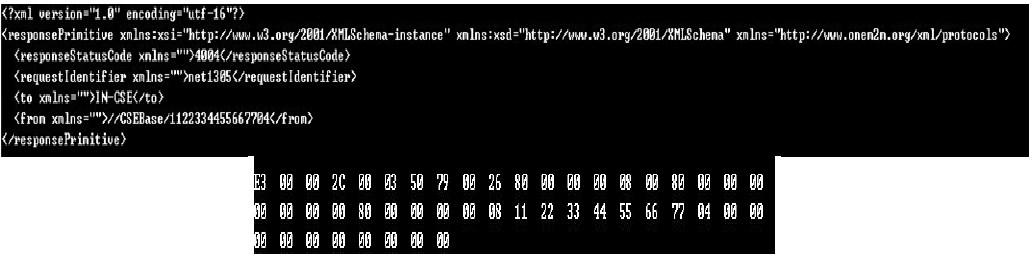
Figure 16. Screen captures of connection establishment (Conversion of a oneM2M Retrieve primitive Response message into an ISO/IEEE 11073 Association Response message).